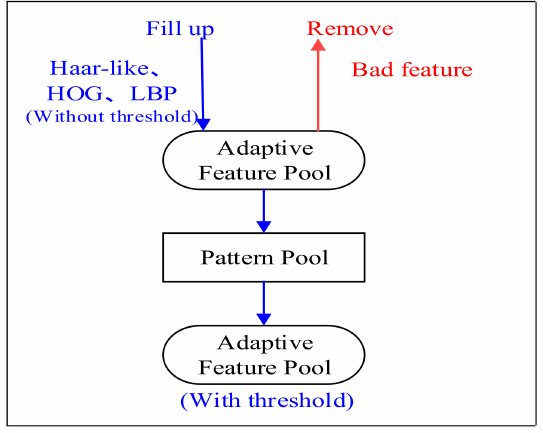
Figure 16. Adaptive feature pool